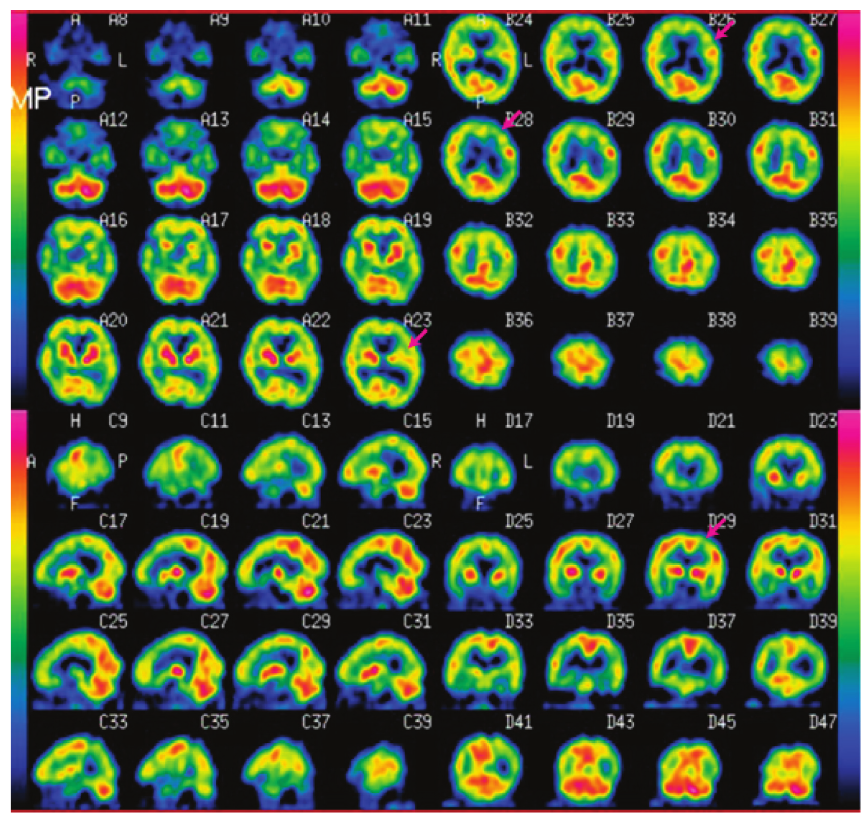
Figure 1: A head image of this patient obtained through single-photon emission computed tomography (SPECT). SPECT detected multifocal hypoperfused areas in the left parietotemporal region and left basal ganglia (red